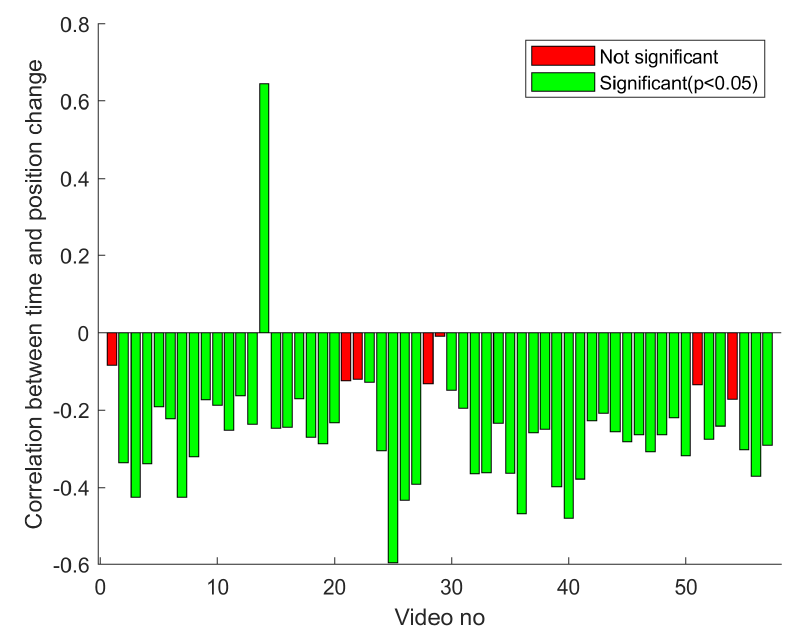
Figure 17. Correlation between position